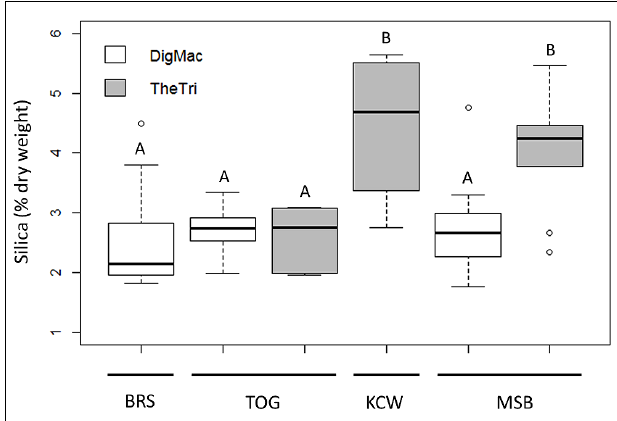
FIGURE 3 | Foliar silica content of each species in relation to plant collection sites. Both species were collected at the intermediate sites, MSB andTOG. Themeda (TheTri) does not occur at the shortgrass plains site BRS, and Digitaria (DigMac) does not occur at KCW in the northern woodlands. Sites are arranged in order of increasing mean annual precipitation: BRS = 498 mm/yr,TOG = 676 mm/yr, KCW = 766 mm/yr, MSB = 891